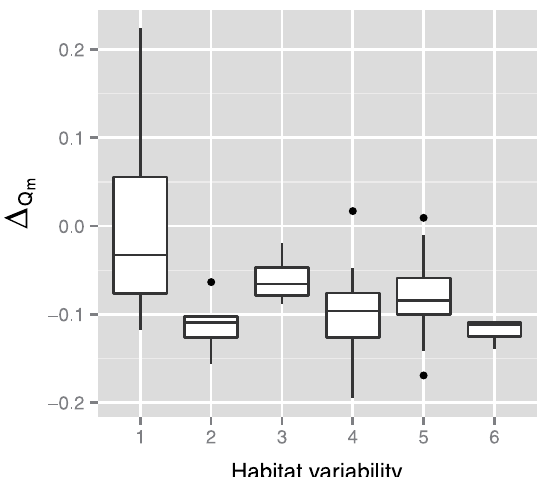
Figure 4. Differences in network modularity between the latest version and earlier version of the metabolic network database. The differences depend on habitat variability ( p =1.9 6 10 2 7 using the Kruskal-Wallis test).